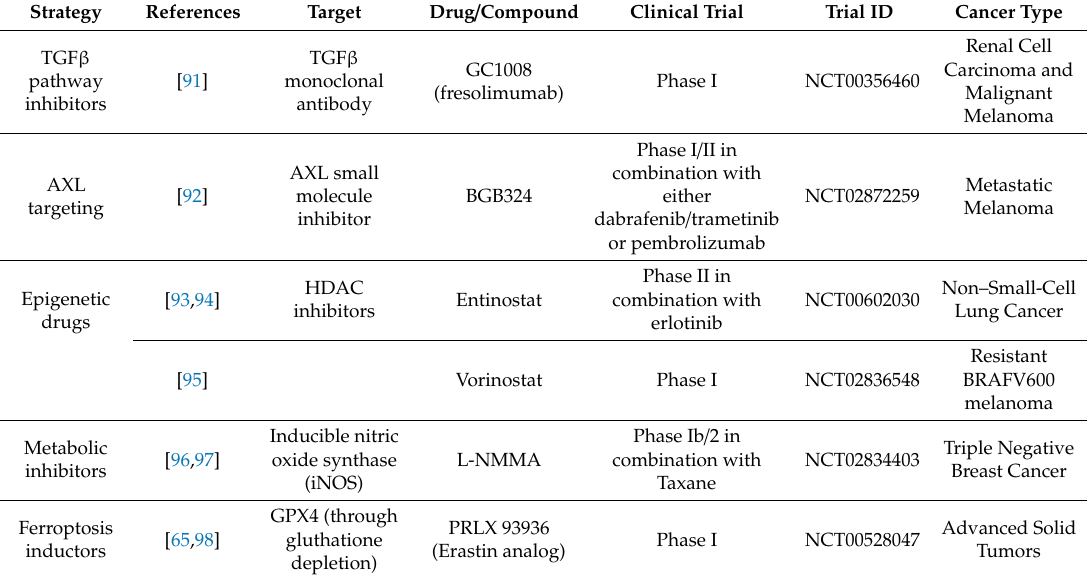
Table 1. Short list of the main therapeutic strategies under evaluation to target EMT-dependent cell plasticity in